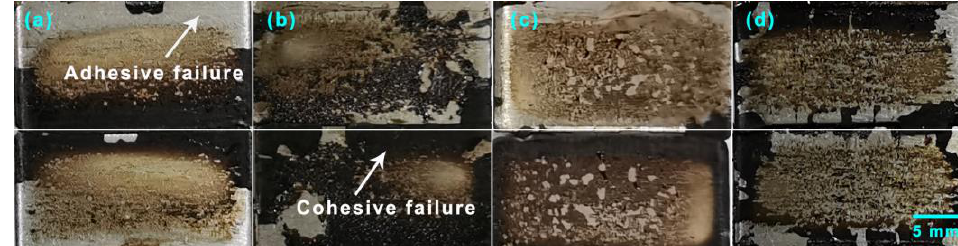
Figure 14. Failure surfaces of steel plates bonded with GNP-reinforced EABCs: EABC ( a ), 0.2% ( b ), 0.5% ( c ) and 1.0% ( d ) after single-lap shear tests at 60 °C.